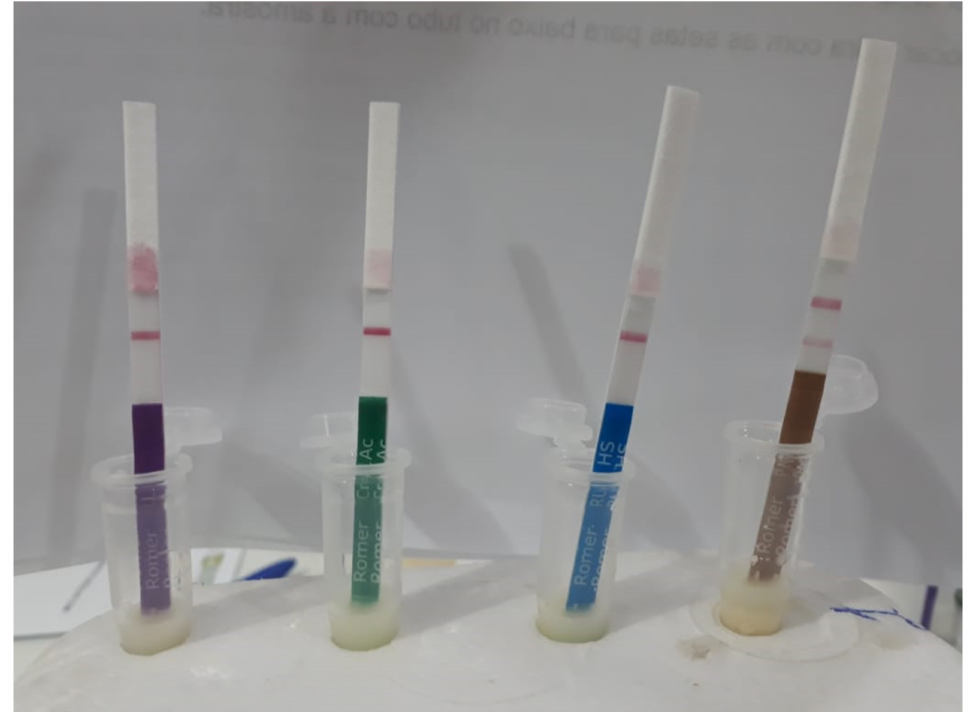
Figure 11. Example of test result carried out with farmers. Two lines indicate positive for GMO presence. Photo credit: Semi-arid Agrobiodiversity Management Program and Agrobiodiversity of the Semi-arid Project image bank. Embrapa Semi á rido Seed Laboratory, Petrolina, Pernambuco, Brazil, January